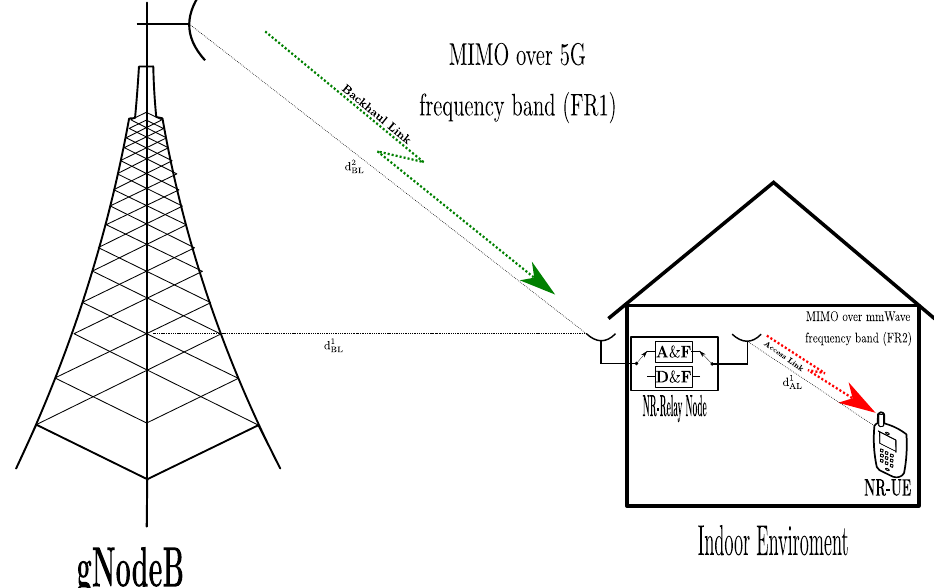
Figure 4. Outdoor-to-Indoor environment scenario with mmWave MIMO